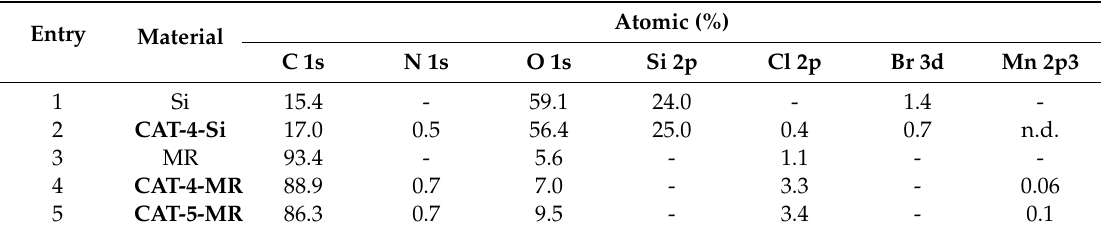
Table 1. Surface atomic percentages for CAT-4-Si , CAT-4-MR and CAT-5-MR obtained by XPS 1